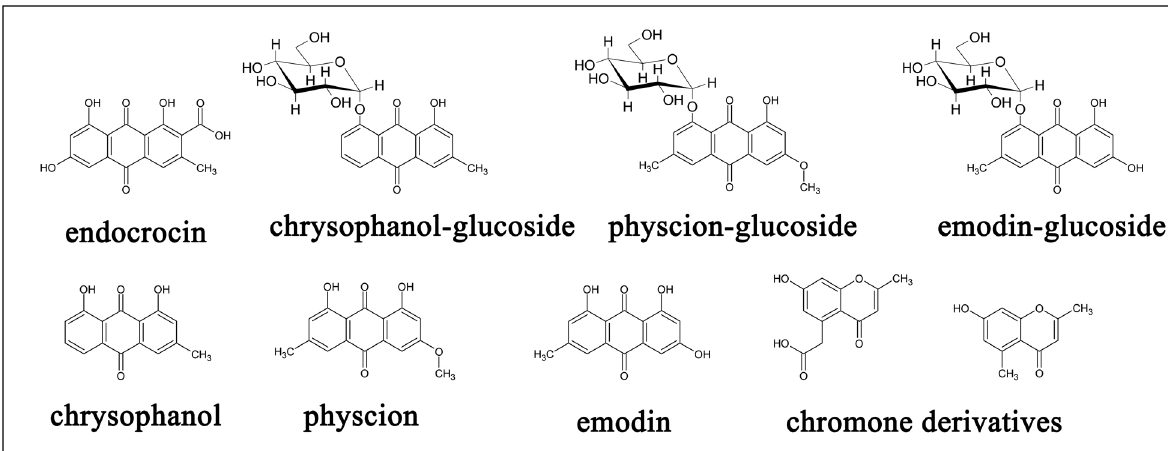
Figure 7. Chemical markers of Rumex dentatus .